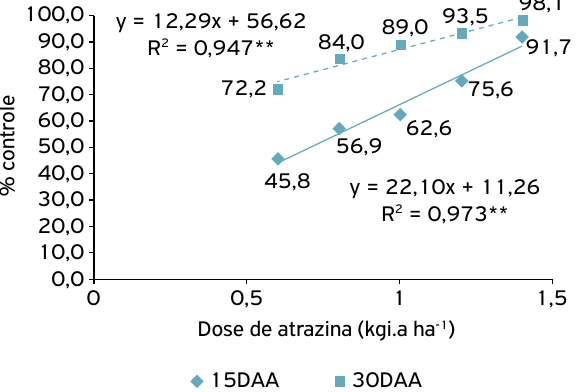
Figura 1. Controle percentual de plantas de soja aos 15